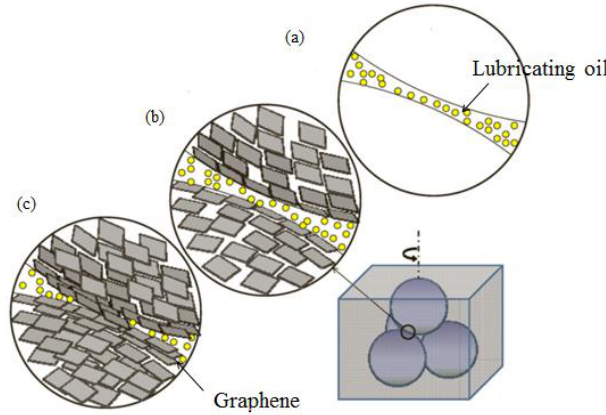
Figure 4. Schematic of the four-ball friction test. ( a ) Friction diagram of pure lubricating oil. ( b ) Represents optimal concentration of graphene in oil. ( c ) Represents excessive concentration of graphene in oil. Reproduced with permission from reference Zhang et al. [83], Copyright 2011, IOP.